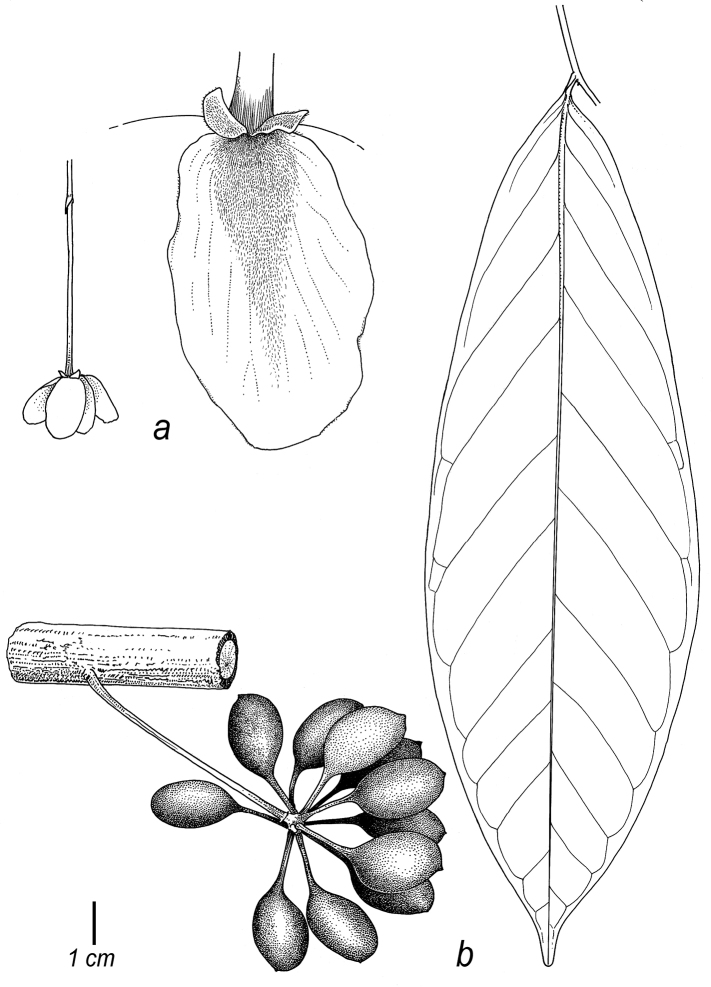
Cremastospermaawaense Pirie. a flower b leaf and fruit (aAulestia 842bVan der Werff 12045).